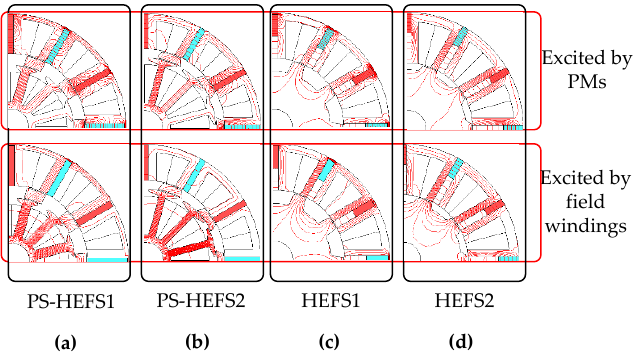
Figure 11. No-load flux distributions of four machines with different excitations. ( a ) PS-HEFS1; ( b ) PS-HEFS2; ( c ) HEFS1; ( d ) HEFS2.